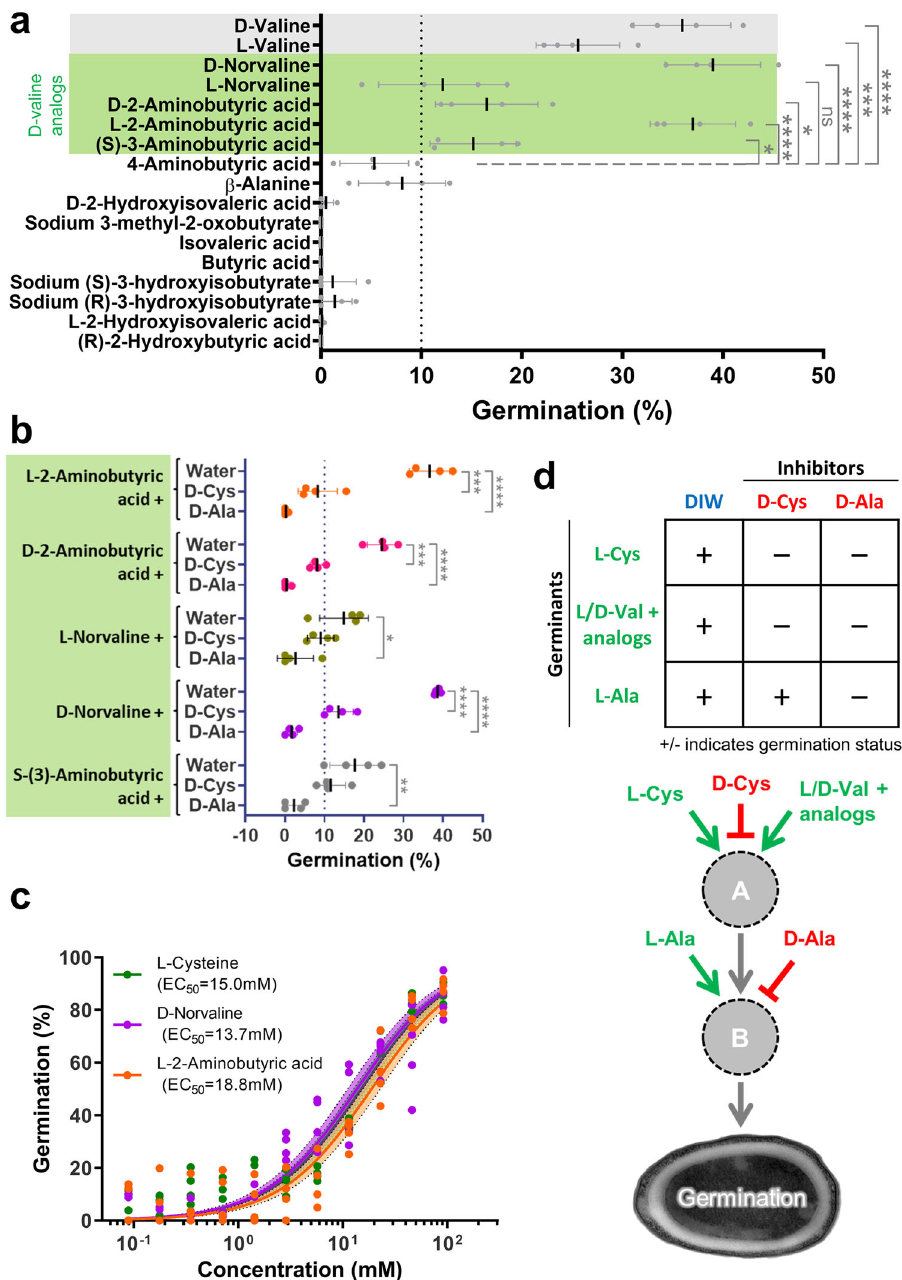
Fig. 6 Germination with D-valine analogs. a Single factor screen of stereoisomeric structural analogs of D-valine. All analogs were at 91.5 mM concentration. D-valine and L-valine were used as reference positive controls (gray). All valine analogs with germination >10% (green) were identi fi ed as germinants. Signi fi cant at **** p ≤ 0.0001,*** p ≤ 0.001,** p ≤ 0.01,* p ≤ 0.05, ns p > 0.05 (unpaired t-test) when compared to 4-aminobutyric acid. b Germination response of valine analogs (91.5 mM) L-2-aminobutyric acid (orange circles), D-2-aminobutyric acid (pink circles), L-norvaline (dark green circles), D-norvaline (purple circles), S-(3)-aminobutyric acid (gray circles) in the presence of the inhibitors D-cysteine and D-alanine (91.5mM concentration). Signi fi cant at **** p ≤ 0.0001,*** p ≤ 0.001,** p ≤ 0.01,* p ≤ 0.05, ns p > 0.05 (unpaired t-test) when compared to corresponding water controls. c Dose response curve for germination response at different concentrations of L-2-aminobutyric acid (orange), D-norvaline (purple) and L-cysteine (green) (normalized to germination with D-valine at the highest concentration 91.5 mM) shows potency of valine analogs similar to L-cysteine. Circles depict individual values. Solid lines depict the least squares fi t regression curve. Shaded area shows the 95% con fi dence error bands for each amino acid fi t. EC 50 values are shown in the legend. d Proposed two-component signaling framework for C. novyi -NT germination. All germination data depict mean ± SD, n = 4 biologically independent samples. Germination % for all graphs are de fi ned in Supplementary Table